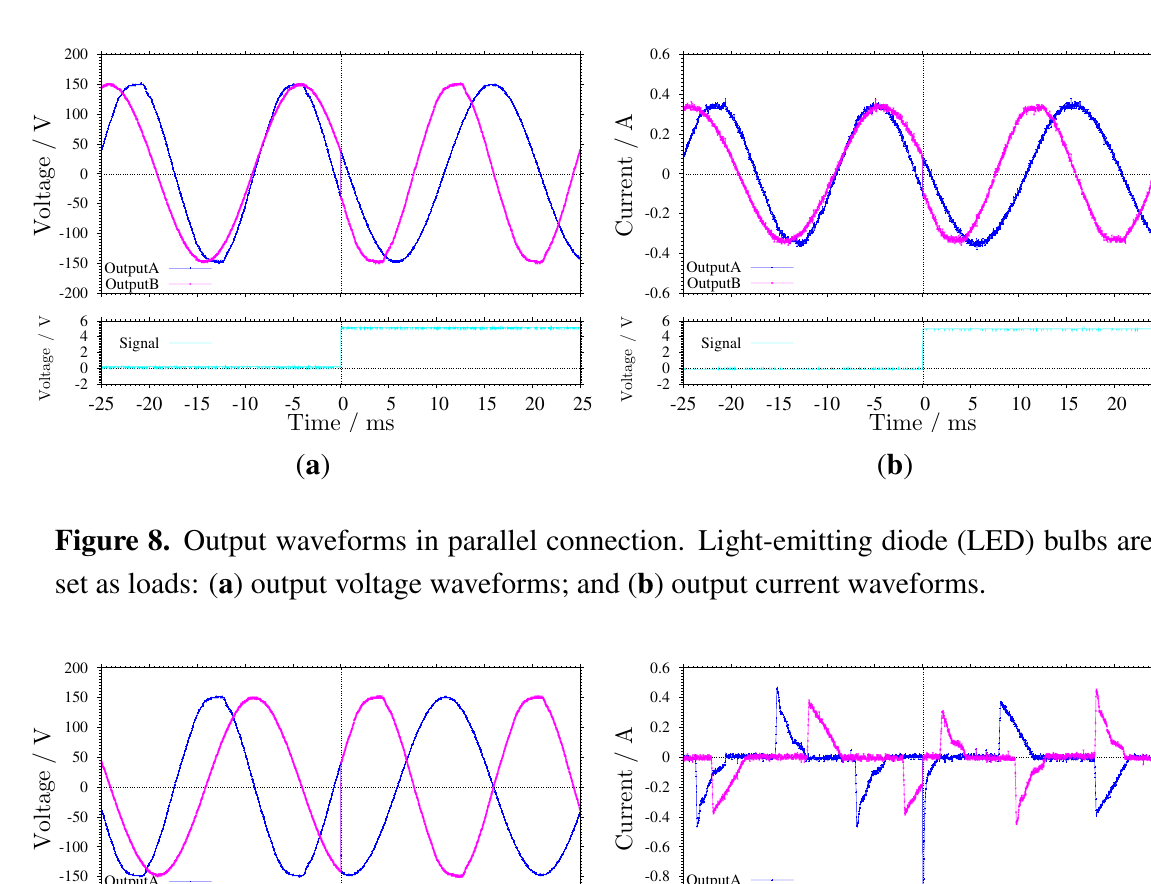
Figure 7. Output waveforms in parallel connection. Incandescent bulbs are set as loads: ( a ) output voltage waveforms; and ( b ) output current waveforms.